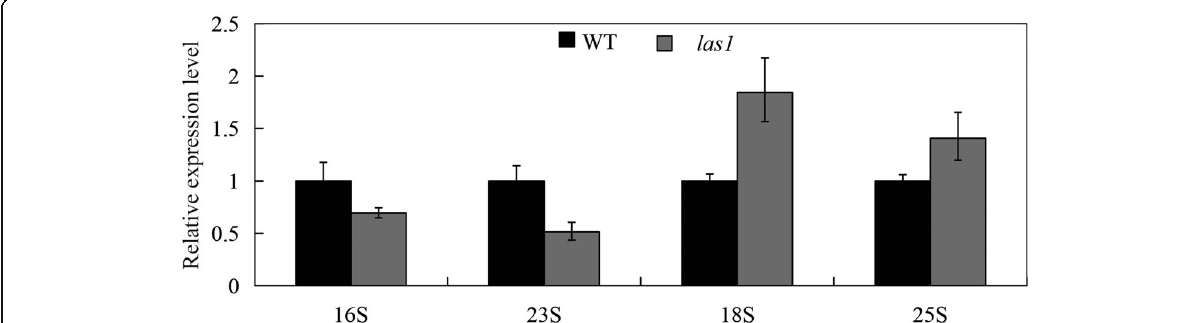
Fig. 8 The expression level of 16 S, 23 S, 18 S and 25 S in wild type and las1 . Error bars represent the SD from three independent